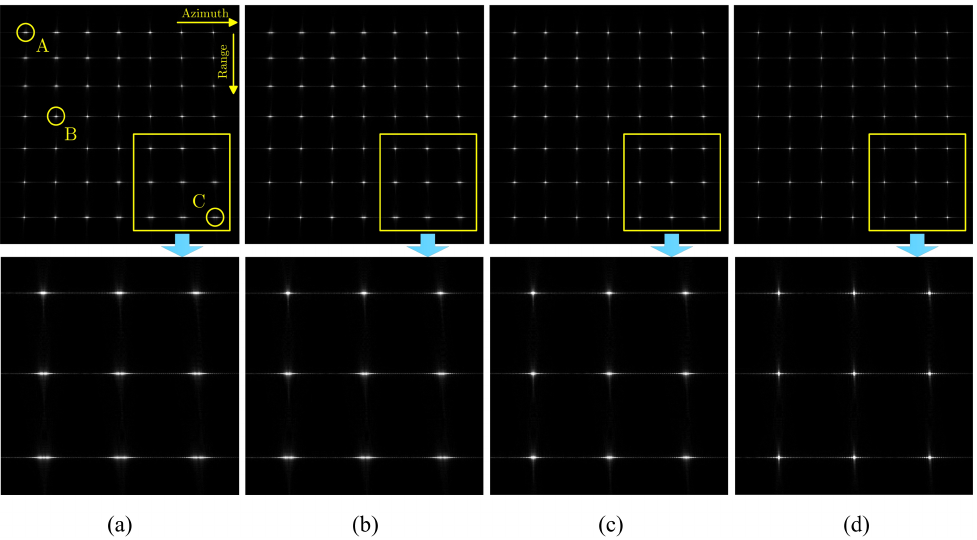
Figure 8. X-band point target simulation and magnified sub-scene. ( a ) Range- and azimuth-variant error interfered image. ( b ) Processed with conventional MDA. ( c ) Processed with